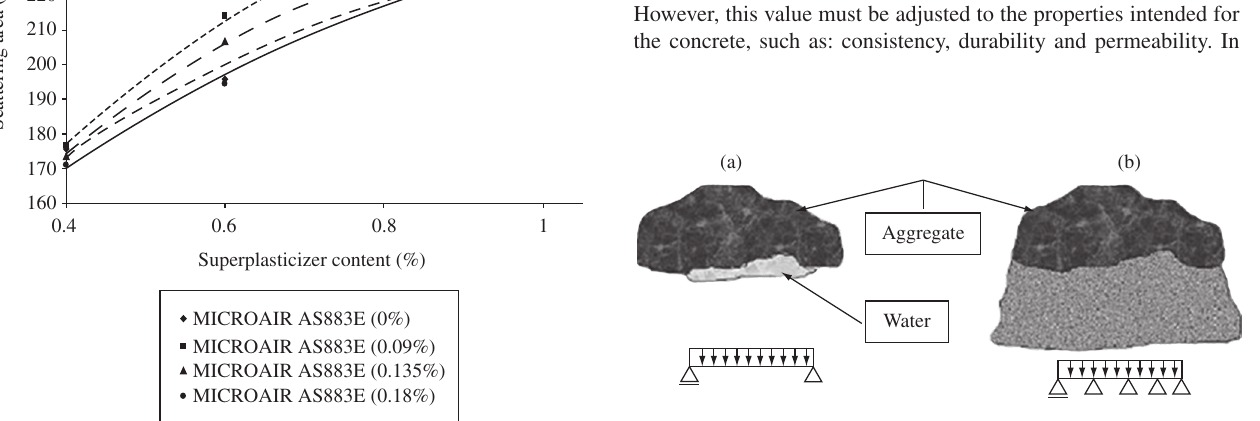
Figure 3. Kantro Test – cement CP II 32 E and superplasticizer Glenium 51 and air incorporated microair AS883E. Source: Lima 9 .